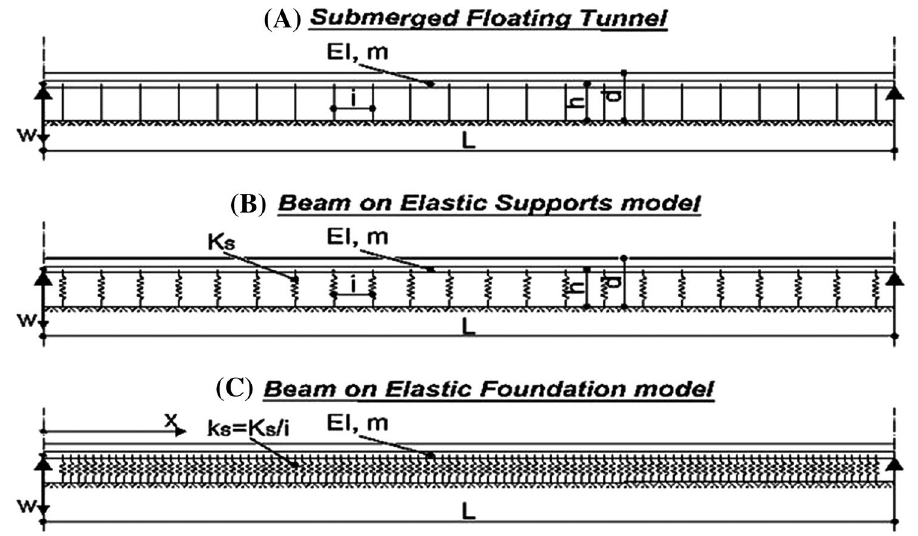
Fig. 3 Idealization of SFT as